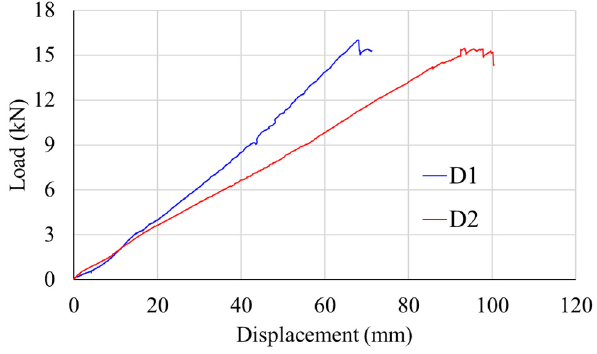
Figure 4. Load-displacement curves.